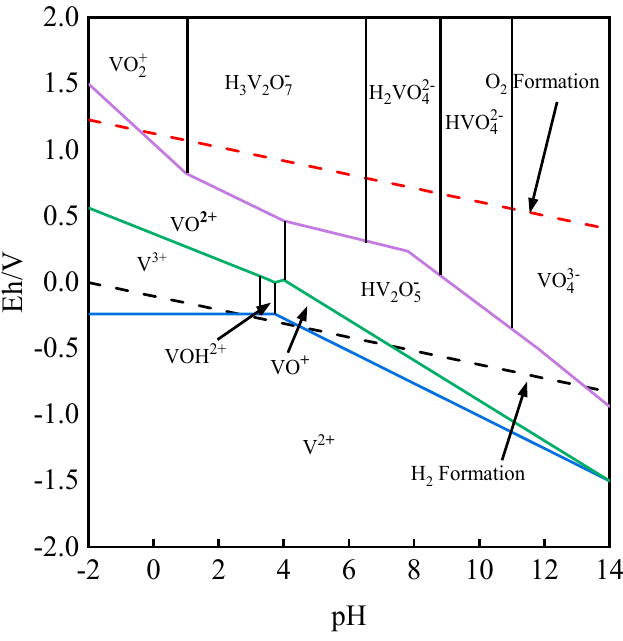
Figure 1. Eh–pH relationship of V-H 2 O system.